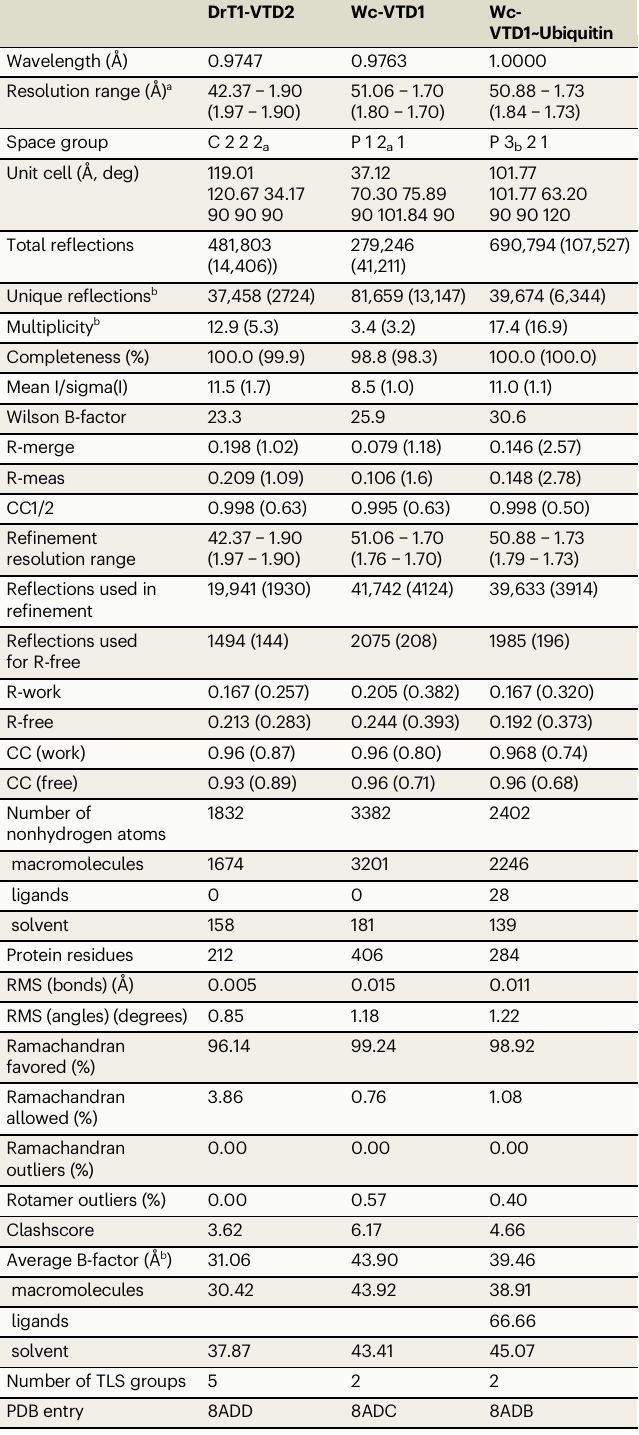
Table 1 | Data collection and re fi nement